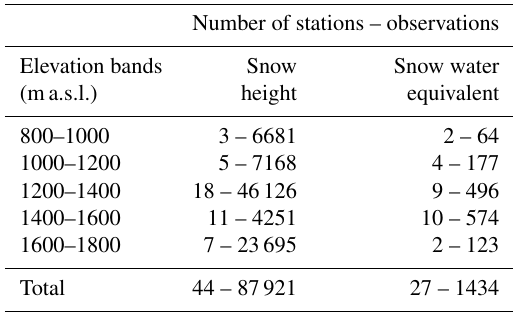
Table 2. Number of snow stations and observations for different elevation bands for the three snow